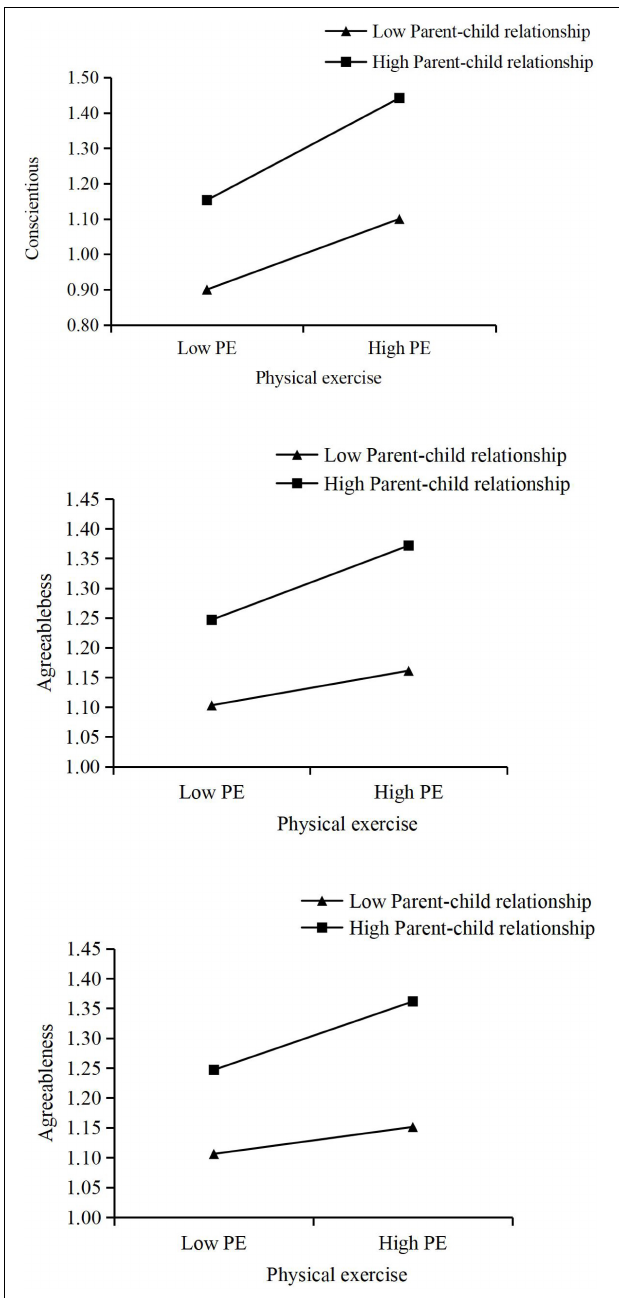
FIGURE 2 | The simple slope indicating the moderation effects. PR, peer relationship; PE, physical